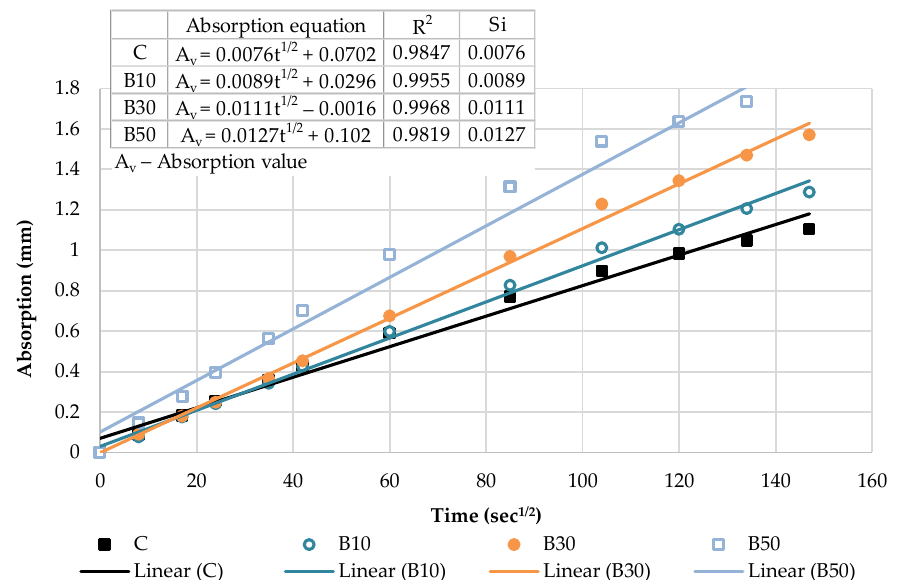
Figure 10. The initial capillary absorptivity of biomass ash–based mortars.